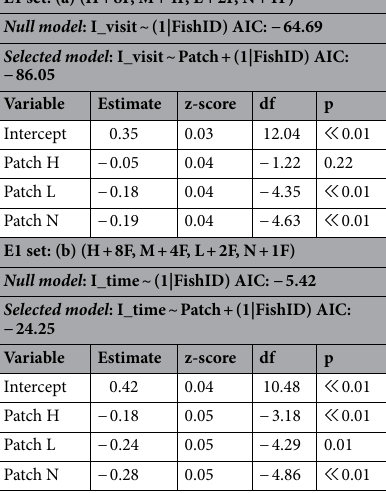
Table 2. Summary of results of generalized linear mixed models indicating effect of patch (female number + vegetation density) and fish id (random factor) on (a) proportion of visits (I_visit), (b) proportion of time spent (I_time), in E1